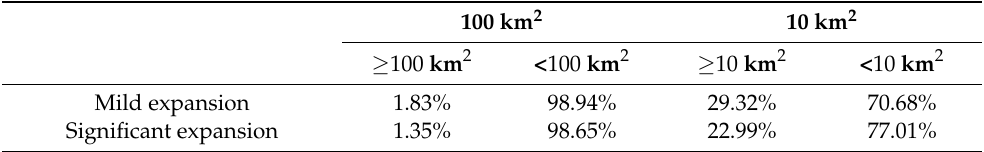
Table 4. Expansion ratio of natural cities in the Yellow River affected